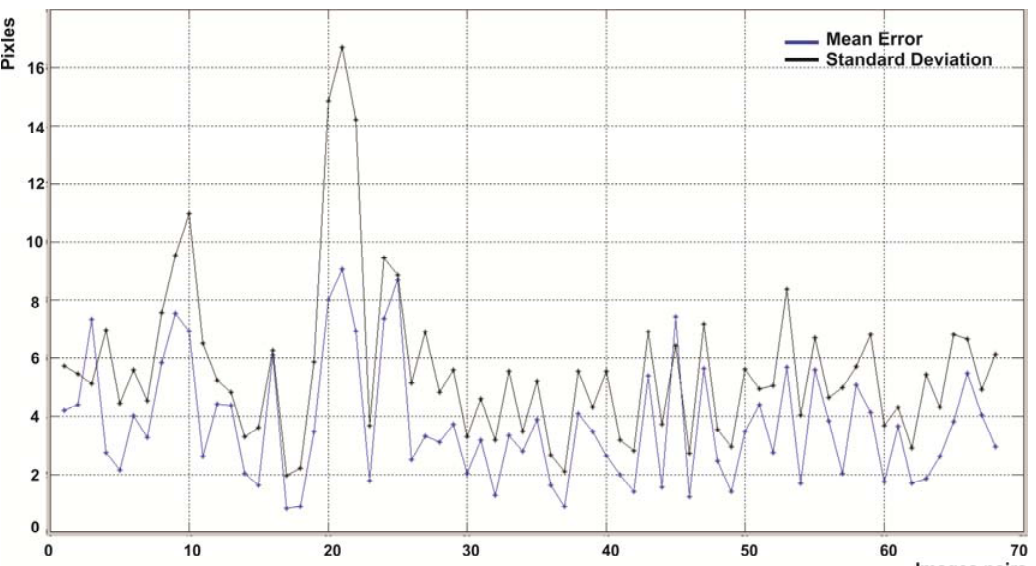
Figure 7. Mean Error and Standard deviation distribution for the images pairs processed by